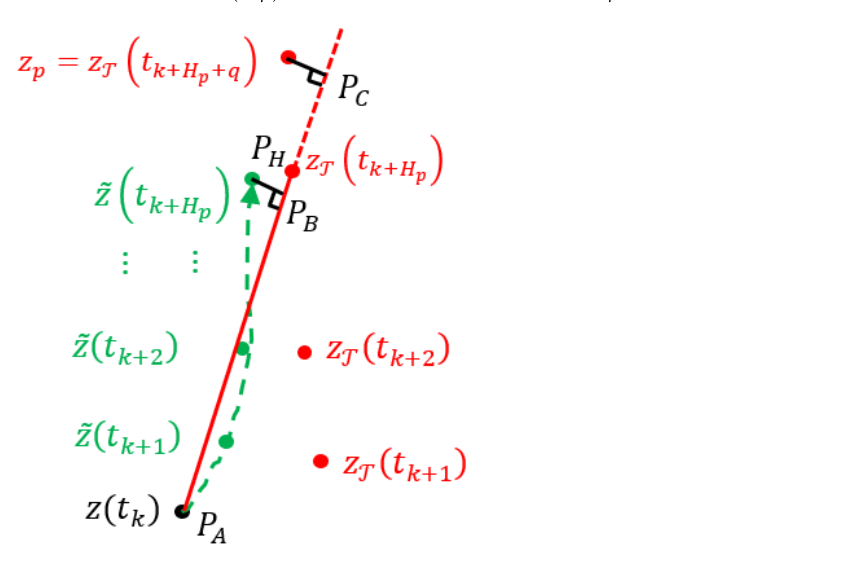
Figure 7. The illustrations of effective distance and pseudo-state.